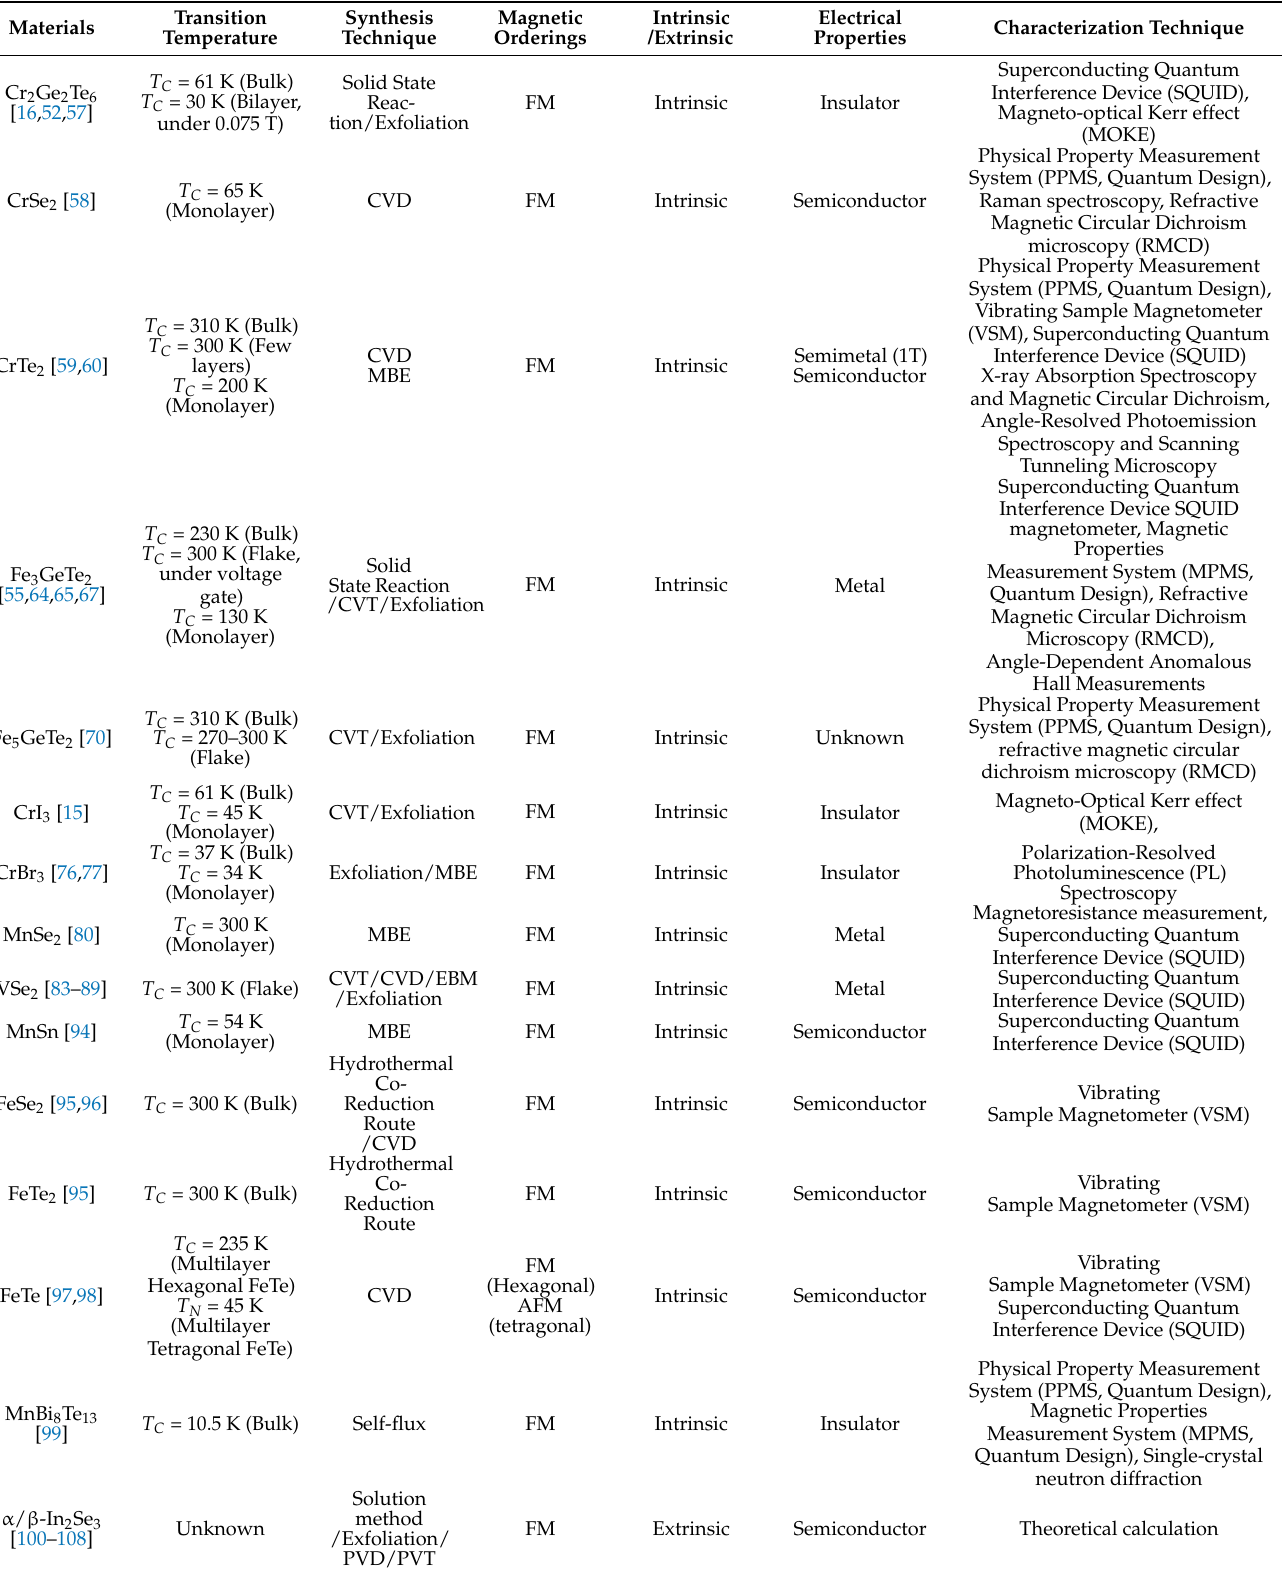
Table 1. Transition temperature, synthesis technique, intrinsic or extrinsic magnetic orderings, electrical properties of 2D vdW magnetic